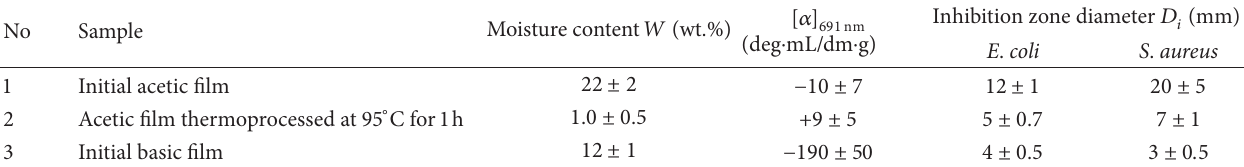
Figure 3: A model for the probable solid-phase transformation of the crystal structure of chitosan upon transition from hydrated (a) to anhydrous form [18]. Table 3: Bactericidal activity of the CTS-87